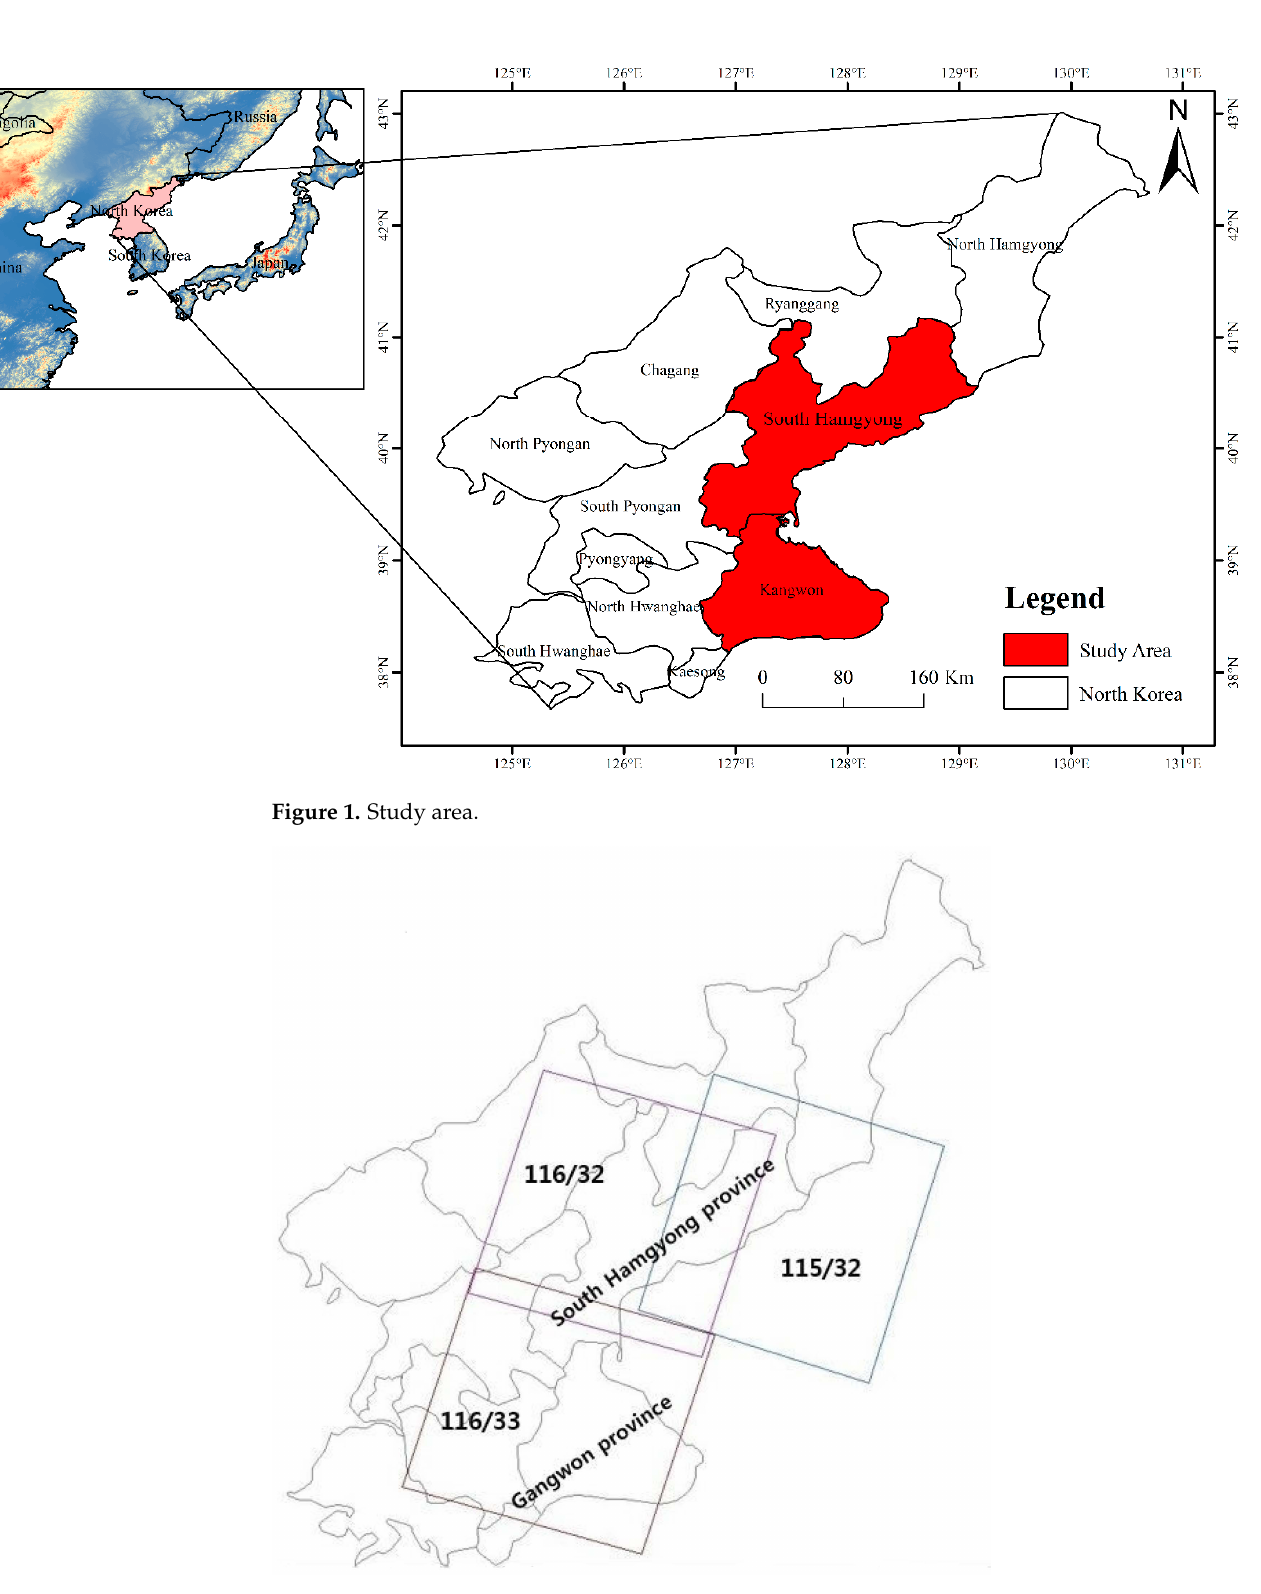
Figure 2. The path and row numbers of Landsat orbits that cover GWP and